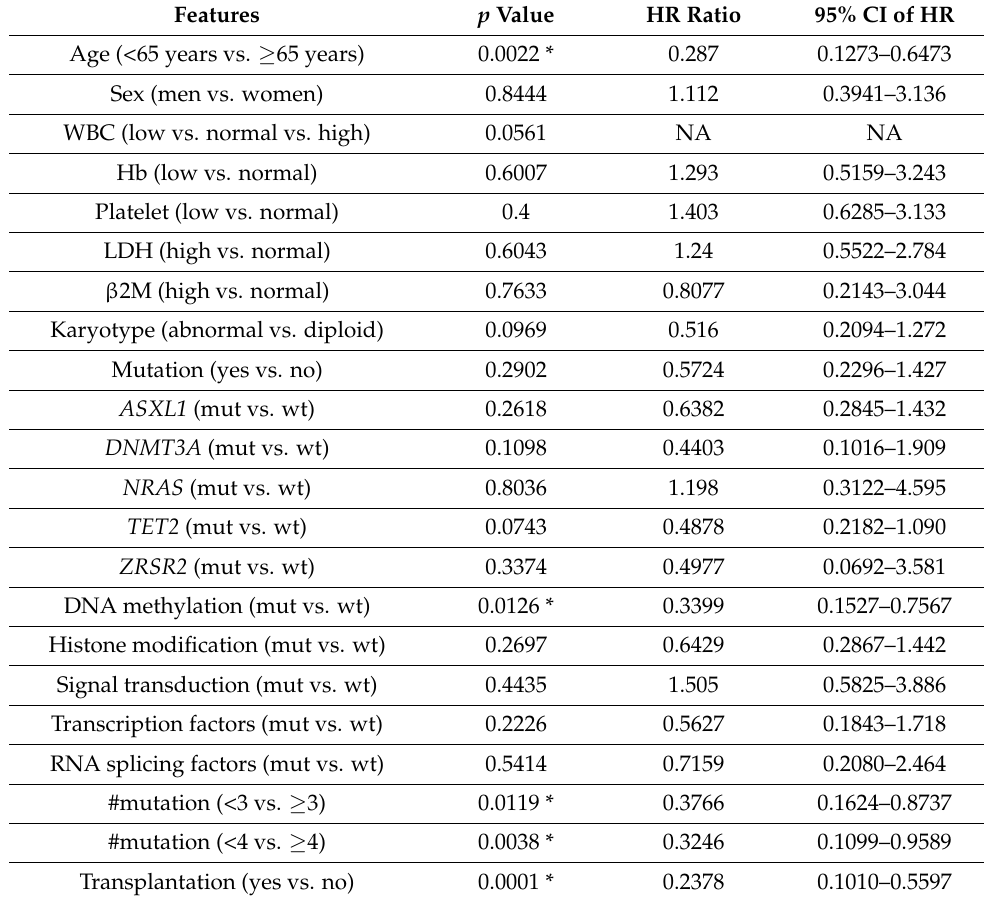
Table 2. Univariate analysis of clinical, laboratory, and molecular genetic data to predict overall